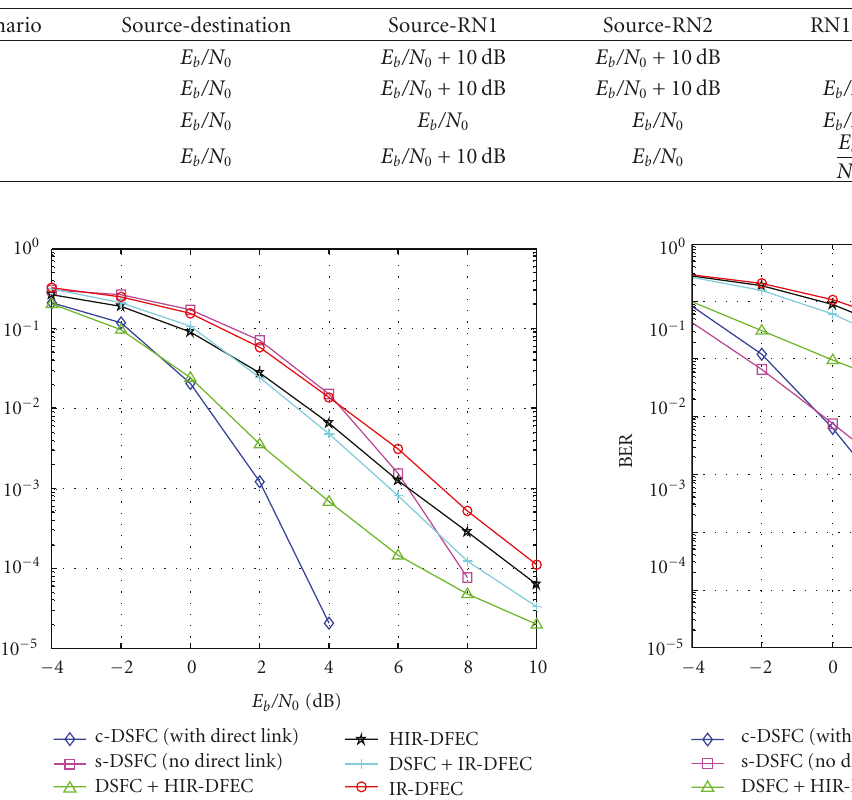
Table 1: Relation between the E b /N 0 link parameters of the defined test scenarios.